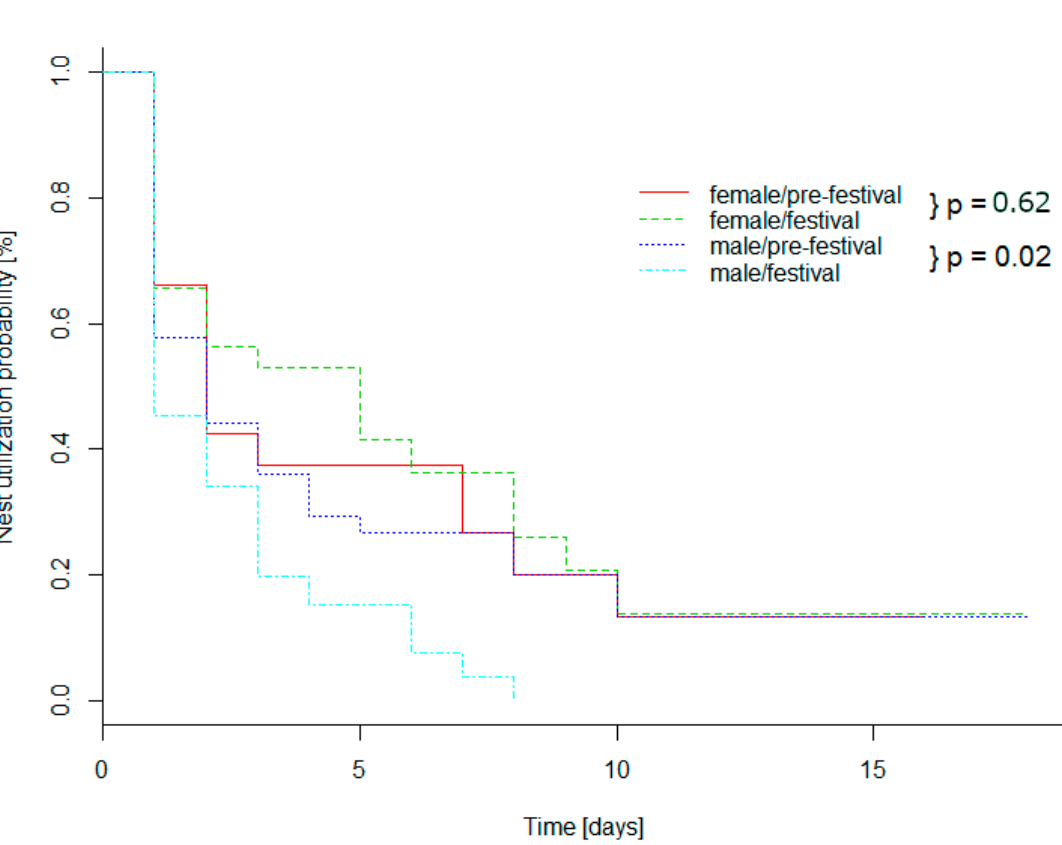
Figure 2. Nest utilization period probability of females and males during pre/after-festival and festival phases, for 17 hedgehogs (nine males, eight females). P -values coming from Log-rank test; females: Log-Rank, N = 88, Mantel, p = 0.83; males: Log-Rank, N = 156, Mantel, p = 0.02.